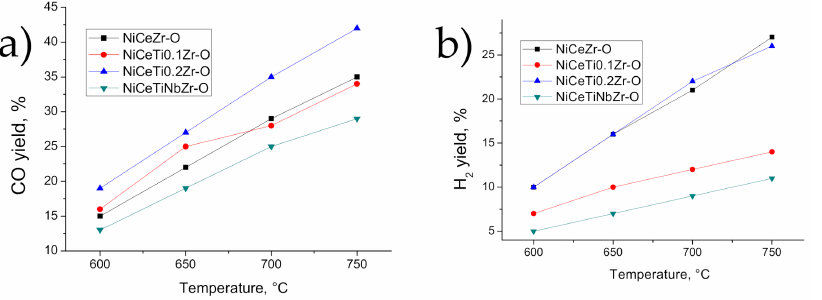
Figure 10. The dependences of ( a ) CO yield and ( b ) H 2 yield on temperature for one-pot samples.